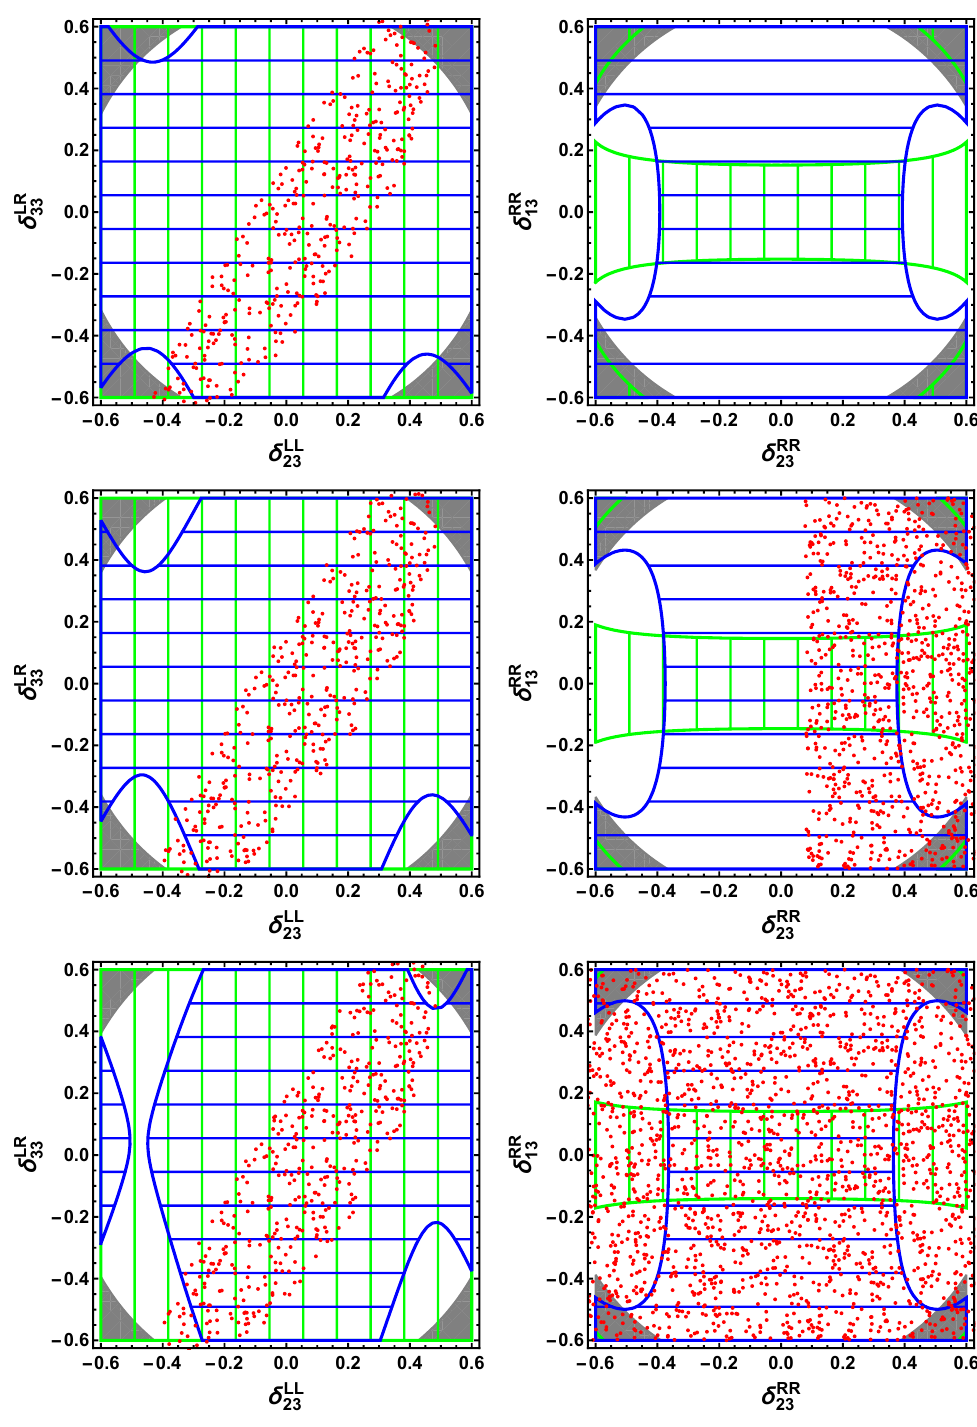
Figure 7 . Allowed regions for (cid:14) LL IIB (right panel). Here (cid:14) LR 1800 (1900) (middle), and 1900 (2000) GeV (lower) in case IB (IIB). The other captions are the same as in (cid:12)gure 6.